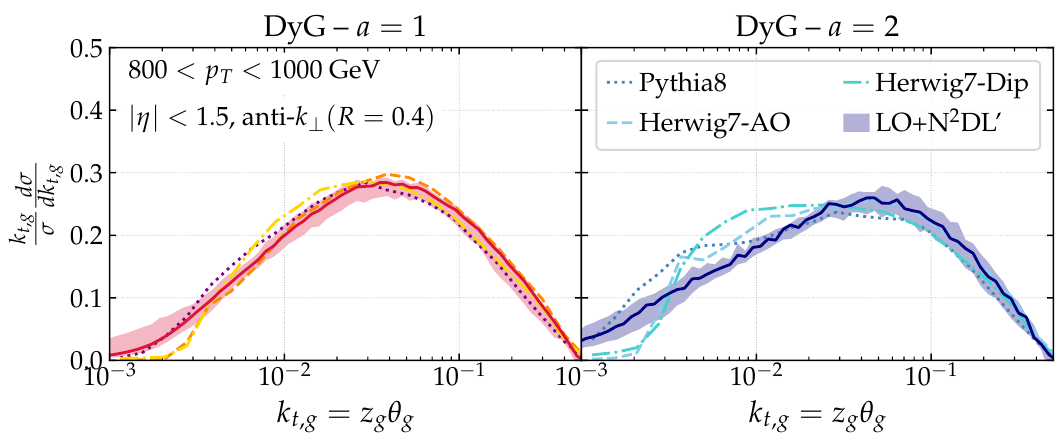
Figure 5 . Theory to parton level comparison of k t,g in the ATLAS-like scenario for a =1 (left) and a =2 (right) in the Dynamical Grooming condition, see eq.